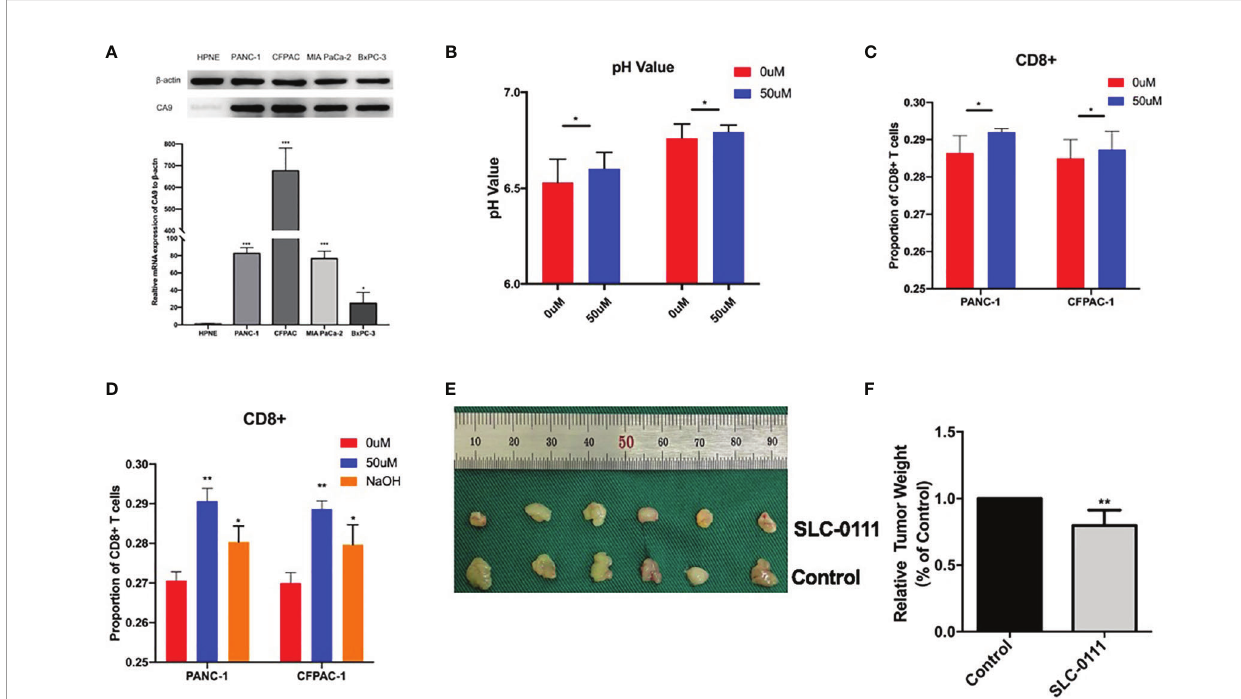
FIGURE 5 | CA9 induce acidic microenvironment and inhibit CD8+ T cells. (A) The expression of CA9 in pancreatic cancer cell lines is signi fi cantly higher than that of normal pancreatic duct cell lines. (B) After adding CA9 speci fi c inhibitor SLC-0111 (50uM), the pH value of the pancreaticcancer culture supernatant is signi fi cantly increased. (C) Adding CA9 inhibitor to pancreatic cancer cell line and PBMC cell co-culture can up-regulate CD8+ T cells. Using NaOH to adjust the pH value to the same as the CA9 inhibitor group partially up-regulate CD8+ T cells. (D, E) In vivo experiments indicate that the C57BL/6 mouse model of tumor formation was randomly divided into two groups after tumor formation, and intraperitoneal injection of normal saline and SLC-0111 for three weeks respectively. Tumors of mice injected with SLC-0111 were signi fi cantly smaller than the control group. * means p<0.05 and ** means